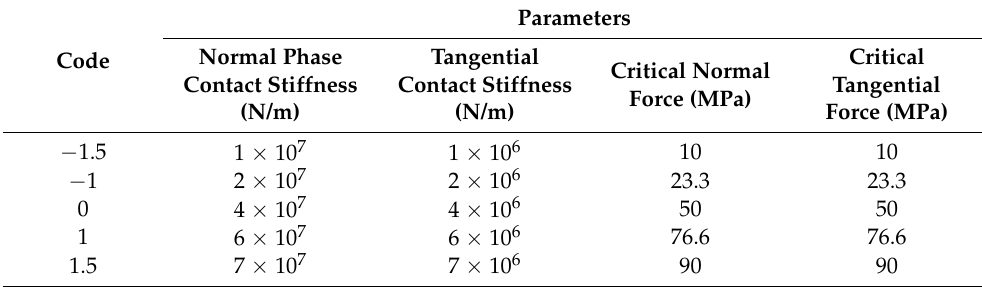
Table 3. Coding of bond parameters.